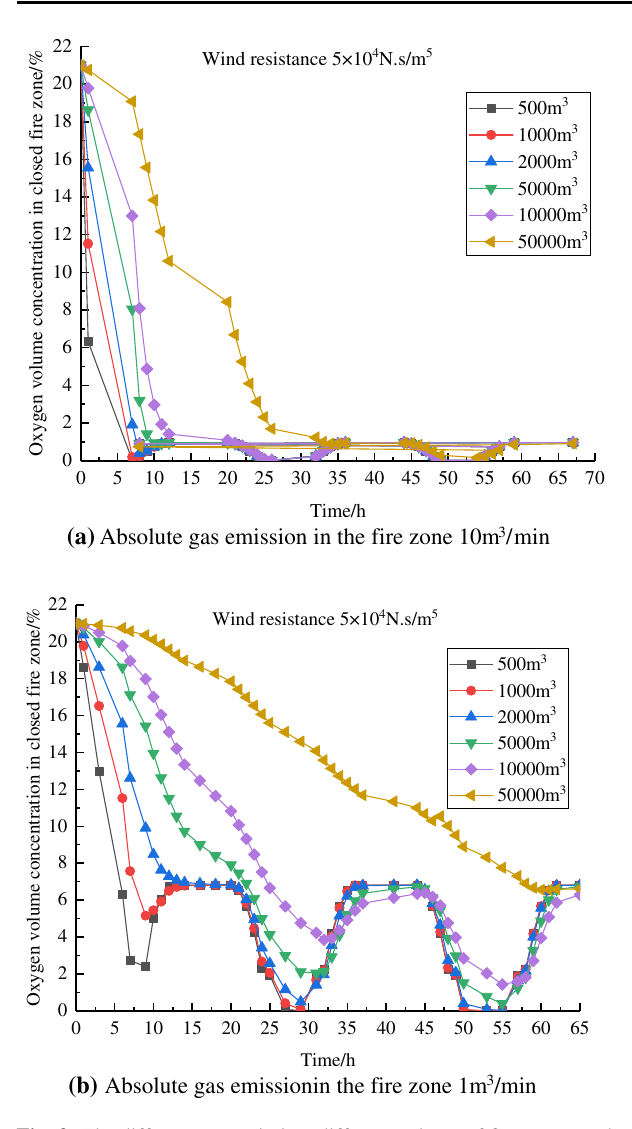
1000, 2000, 5000, 10,000 and 50,000 m 3 fire zones reach